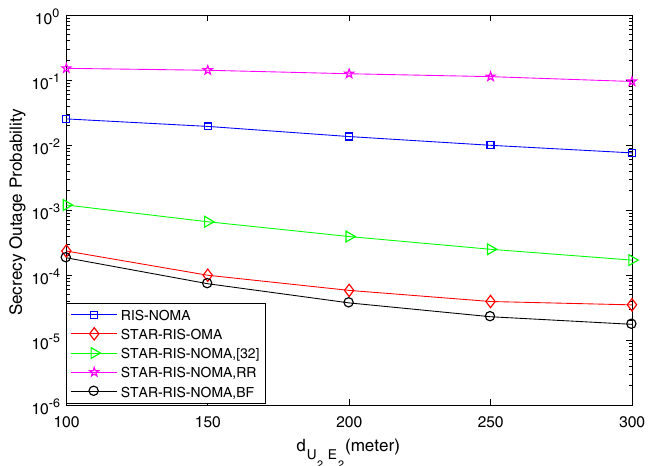
Fig. 6 The SOP versus the different distances from the cell-center user to eavesdropper, i.e., d U 2 E 2 . When the transmission power is constant, the influence of different distances on the